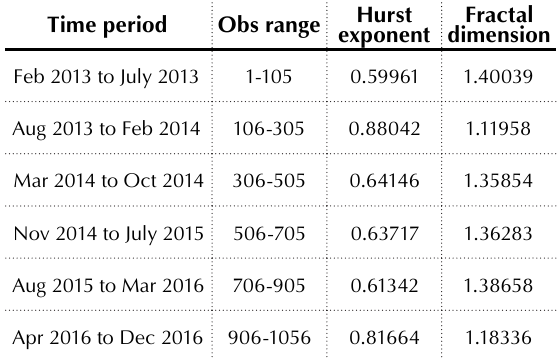
Table 4. Hurst e xponent: